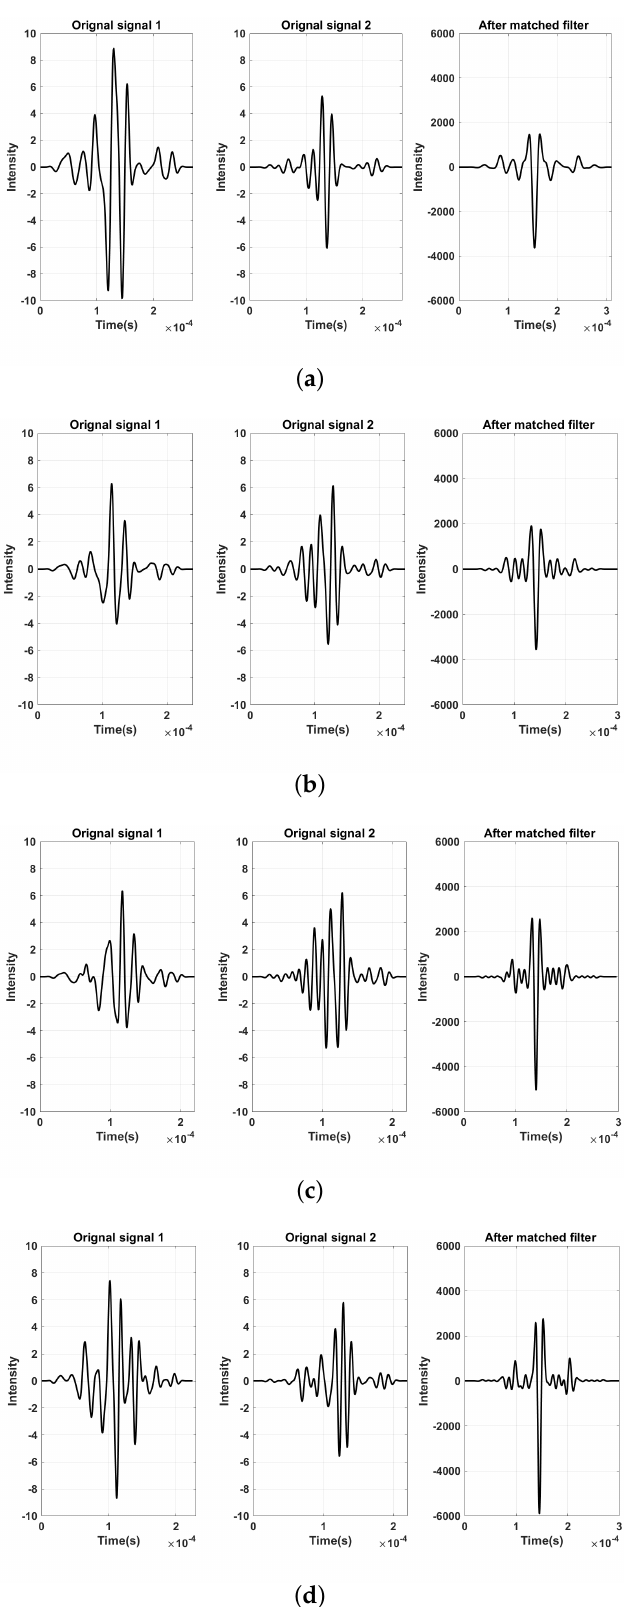
Figure 11. The central line of the 2-bit Golay code combine different length Barker code pairs’ simulation results. ( a ) The original and processed B5G2 pair signals. ( b ) The original and processed B7G4 signals. ( c ) The original and processed B11G8 pair signals. ( d ) The original and processed B13G2 pair